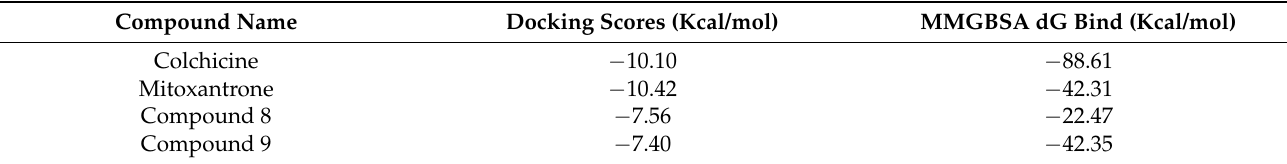
Table 4. The Glide docking scores and prime MM-GBSA energy